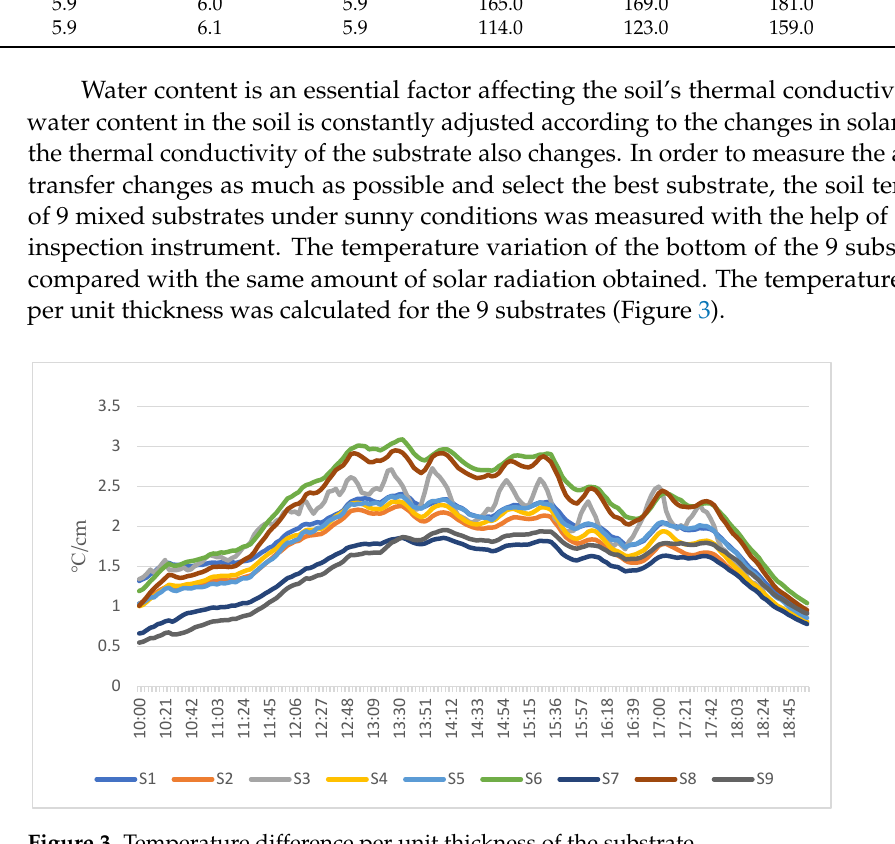
Figure 3. Temperature difference per unit thickness of the substrate.